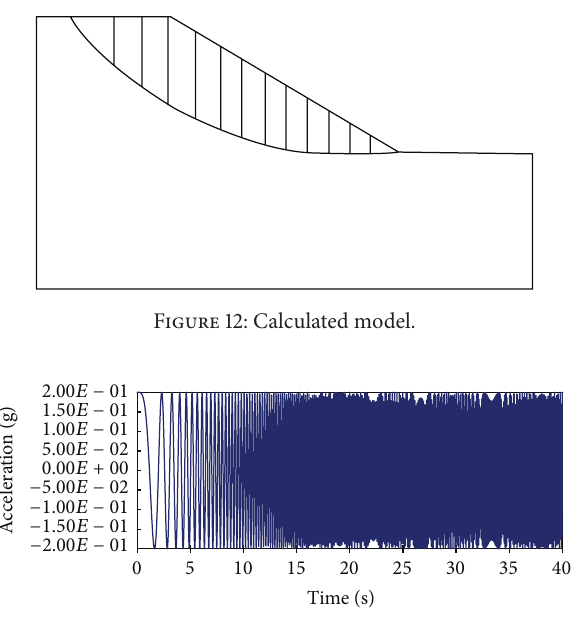
Figure 13: Time history of sine wave.